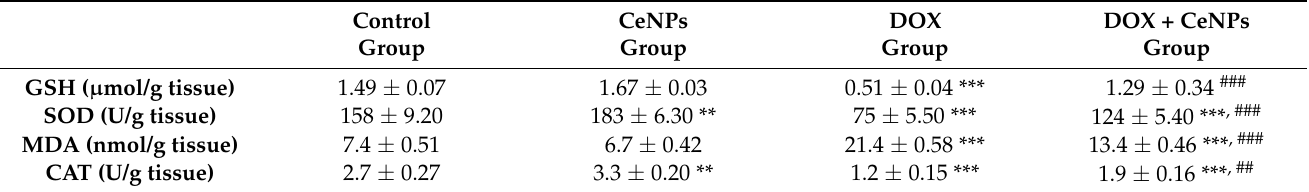
Table 1. Effect of nanoceria on oxidative stress markers (GSH, SOD, MDA and CAT) in rats’